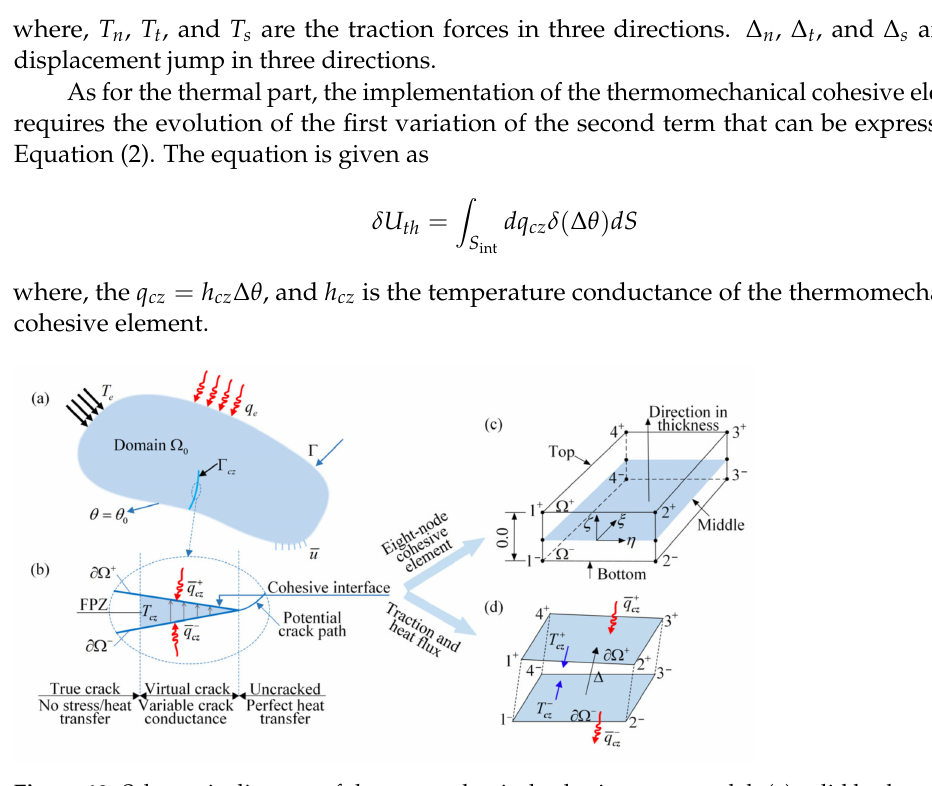
Figure 10. Schematic diagram of thermomechanical cohesive zone model: ( a ) solid body with the thermomechanical cohesive interface; ( b ) cohesive zone model; ( c ) eight − node cohesive element; ( d ) traction and heat flux in cohesive